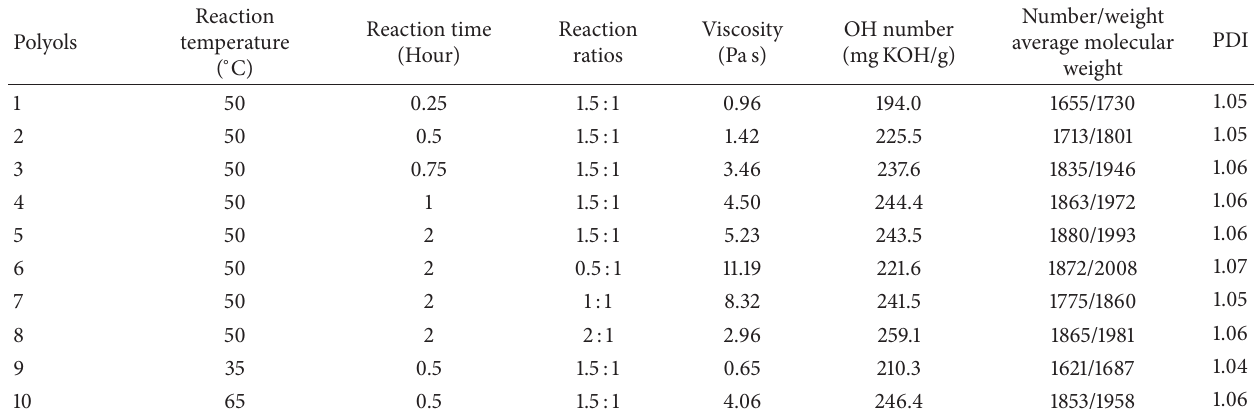
Figure 5: FT-IR spectra of ESBO and polyols with different reaction time. Table 3: Polyols prepared from ESBO-COD